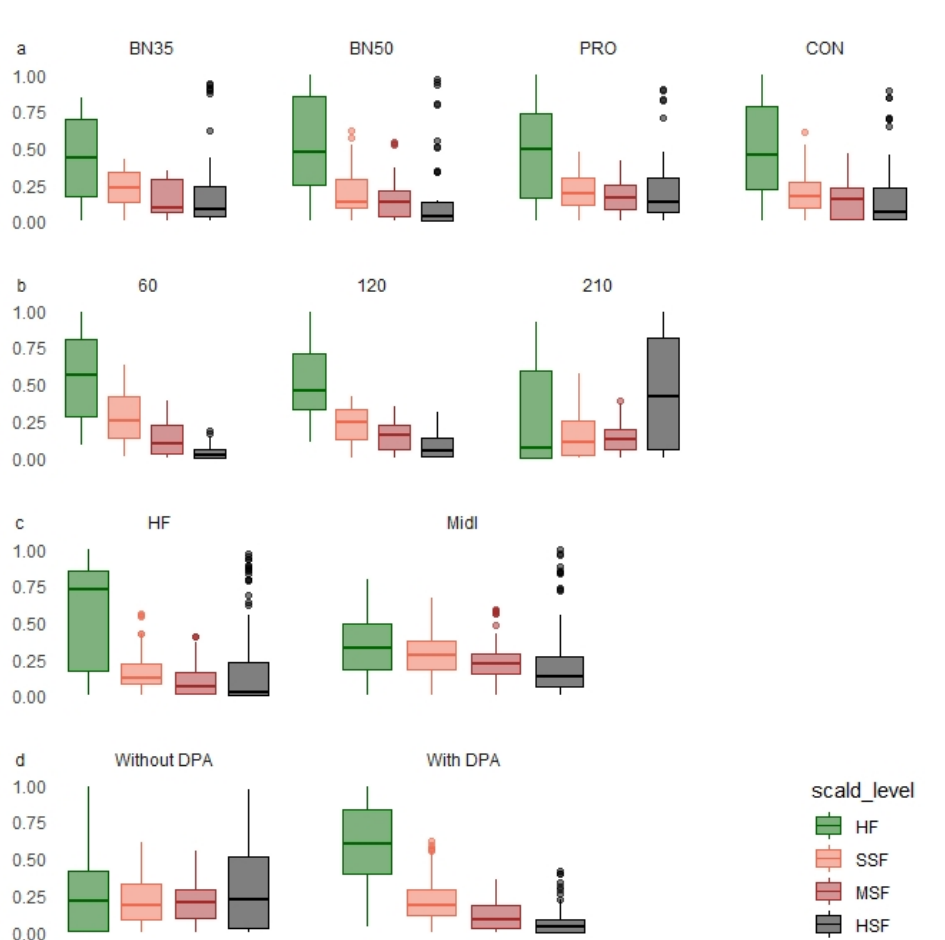
Figure 9. Proportion of fruits at each level of scald (HF healthy fruit, SSF = slightly scalded fruit, MSF = moderately scalded fruit, HSF = heavily scalded fruit) for season 2, according to: ( a ). field treatment (BN35 = Black net 35, BN50 = Black net 50, CON = control and PRO = protectants), ( b ). days of storage, ( c ). sun damage at harvest (HF, healthy fruit; Mild, light sunburn), and ( d ). post-harvest treatment (without DPA or with DPA). The box represents interquartile range (IQR); the upper (Q3) and lower (Q1) quartiles are the ends. The line in the box is the median and the whiskers are the range of the data, excluding outliers. Outliers are values higher than Q3 + 1.5 IQR or smaller than Q1 − 1.5 IQR.